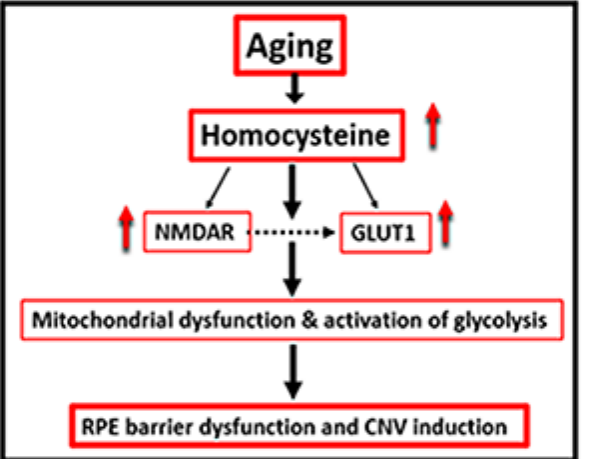
Figure 8. Conclusion for our hypothesis about the role of homocysteine in AMD induction via stimulating NMDAR and GLUT1 producing RPE barrier dysfunction and